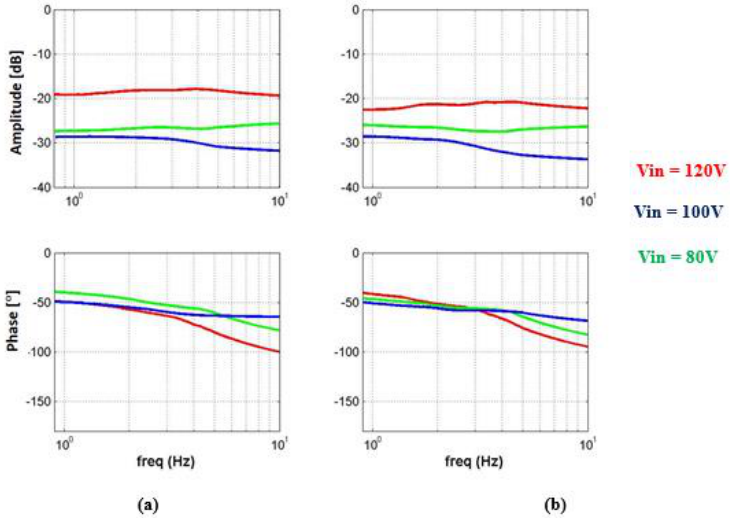
Figure 12. Bode plot of the output angle as a function of input voltage amplitude and load: ( a ) First load and ( b ) second load.